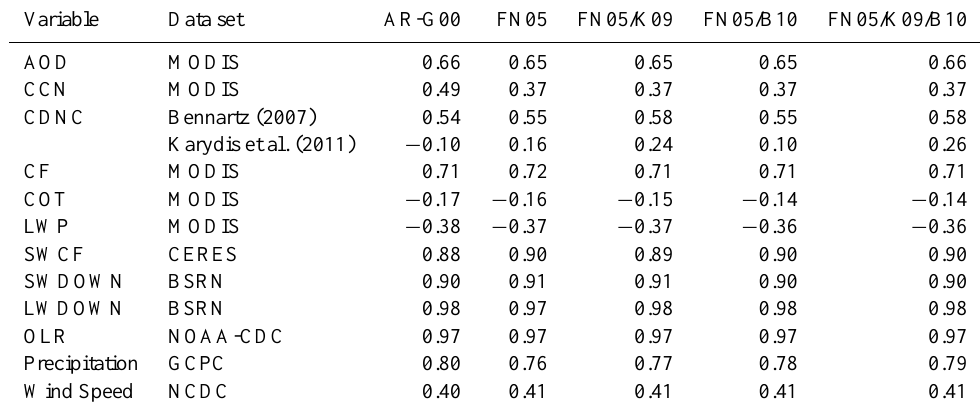
Table 3. Annual mean correlation coefficients of the CESM-CAM5-predicted meteorological/radiative variables. Variable